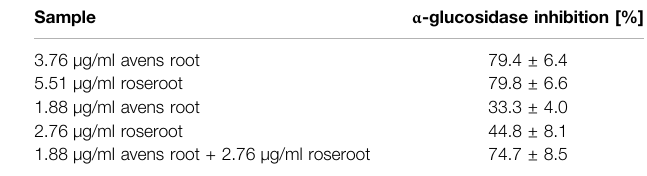
Avensrootandroserootextractsweretestedfortheireffectson α -glucosidaseactivityat concentrations corresponding to the calculated IC 50 values given in Table 1 (3.76 and 5.51 μ g/ml)andtherespectivehalfvalues.Toelucidateputativesynergisticeffects,both extractswerealsoappliedincombinationatconcentrationsrepresentingtheircalculated half IC 50 values. Data represent means ± SEM of three independent